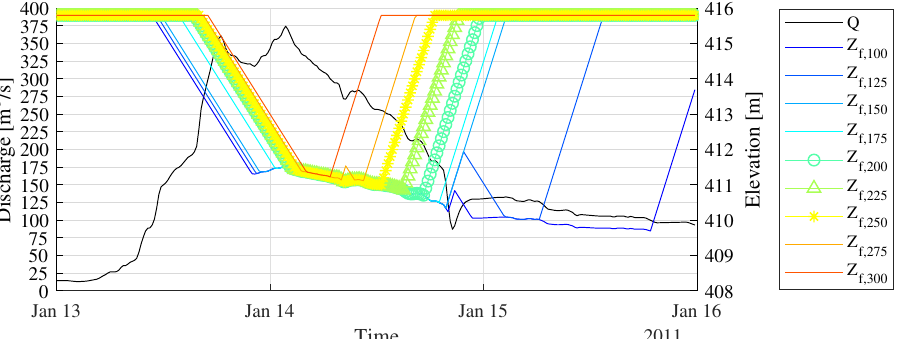
Figure 3. Time-series of the flow (Q) and the nine different developed scenarios, represented by the water surface elevation (Z f,i ) for one exemplary flow situation.